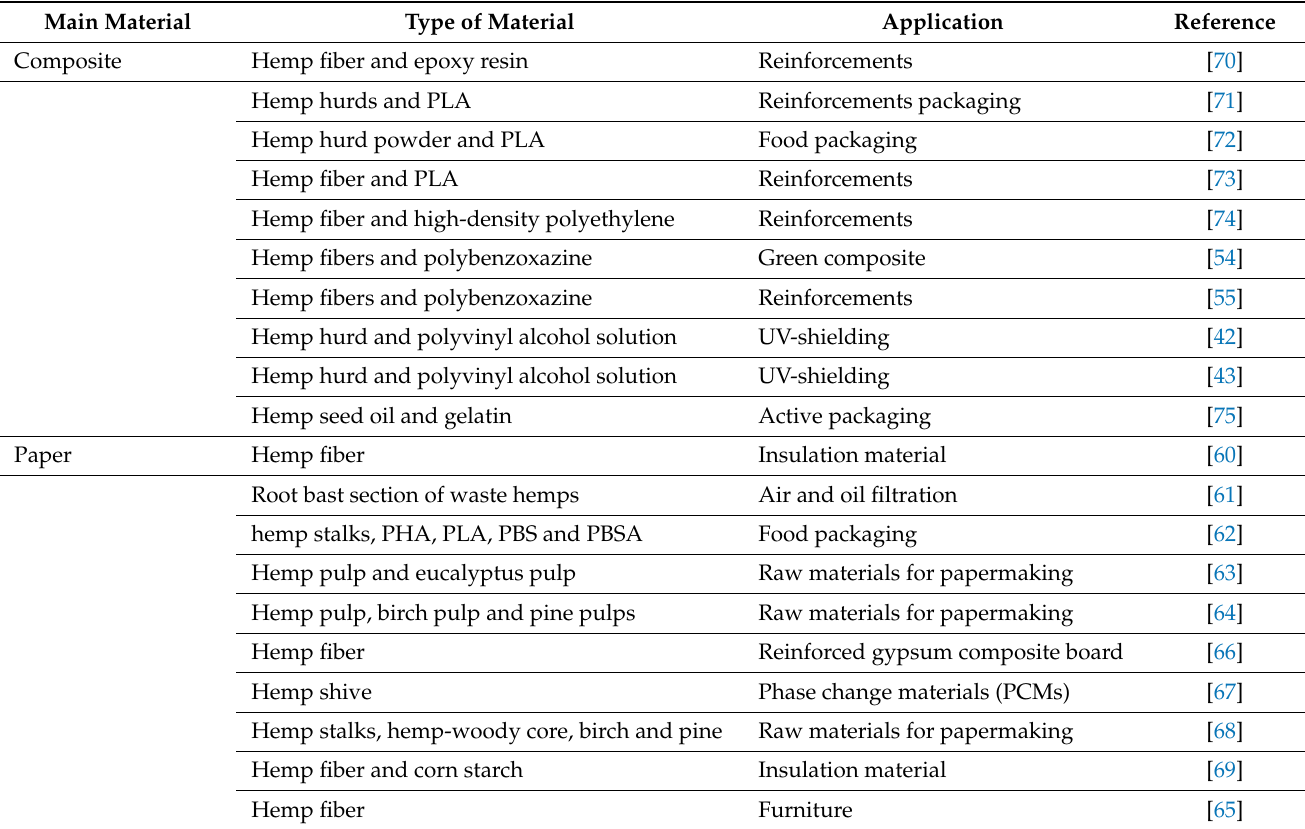
Table 2. Applications of hemp fiber in composite materials and paper.